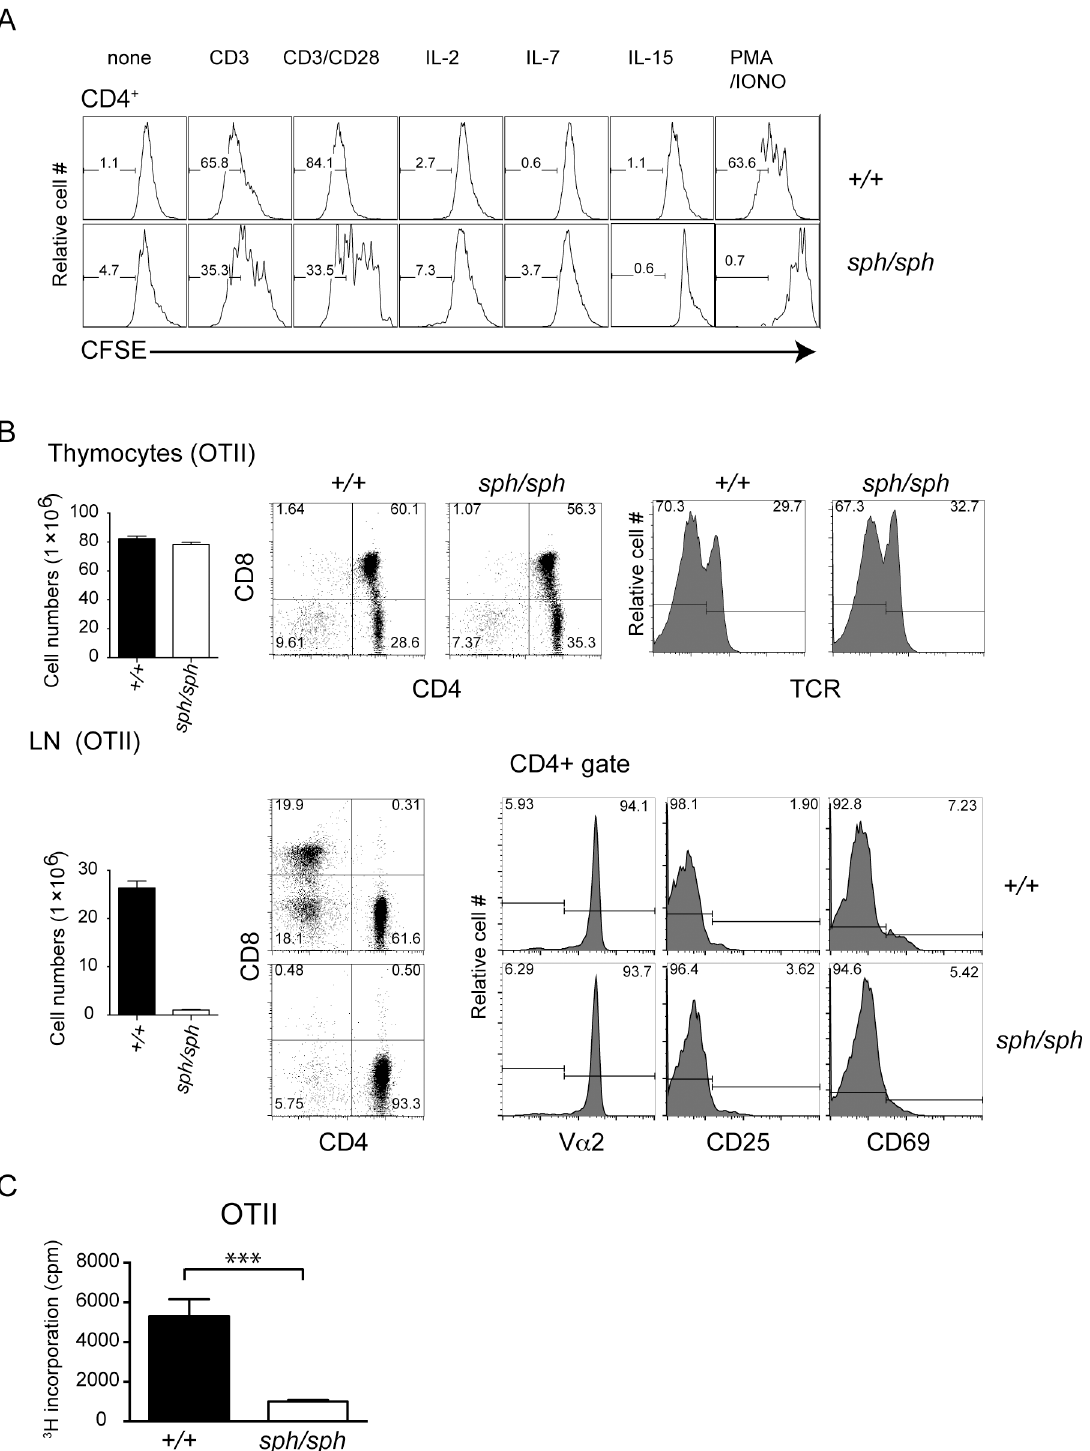
Fig 2. Gimap5 deficiency results in the absence of proliferative response to cognate antigen in CD4 + T cells. (A) CFSE-labeled polyclonal lymphocytes from wildtype and Gimap5 sph/sph mice were cultured with anti-CD3 antibody, anti-CD3&CD28 antibodies, IL-2 (10 ng/ml), IL-7 (5 ng/ml), IL-15 (10 ng/ml) or PMA/Ionomycin for 3 to 5 days. Medium and cytokines were replenished on day 3. The representative histogram shows CFSE dye dilution, indicative of proliferation in the gated CD4 + T cells. Cultures stimulated with IL-2, IL-7 and IL-15 were analyzed on day 5. Unstimulated cultures and cultures stimulated with anti-CD3 or anti-CD3/CD28 antibodies and PMA/inomycin were analyzed on day 3. (B) Flow cytometric analysis of thymocytes and lymph